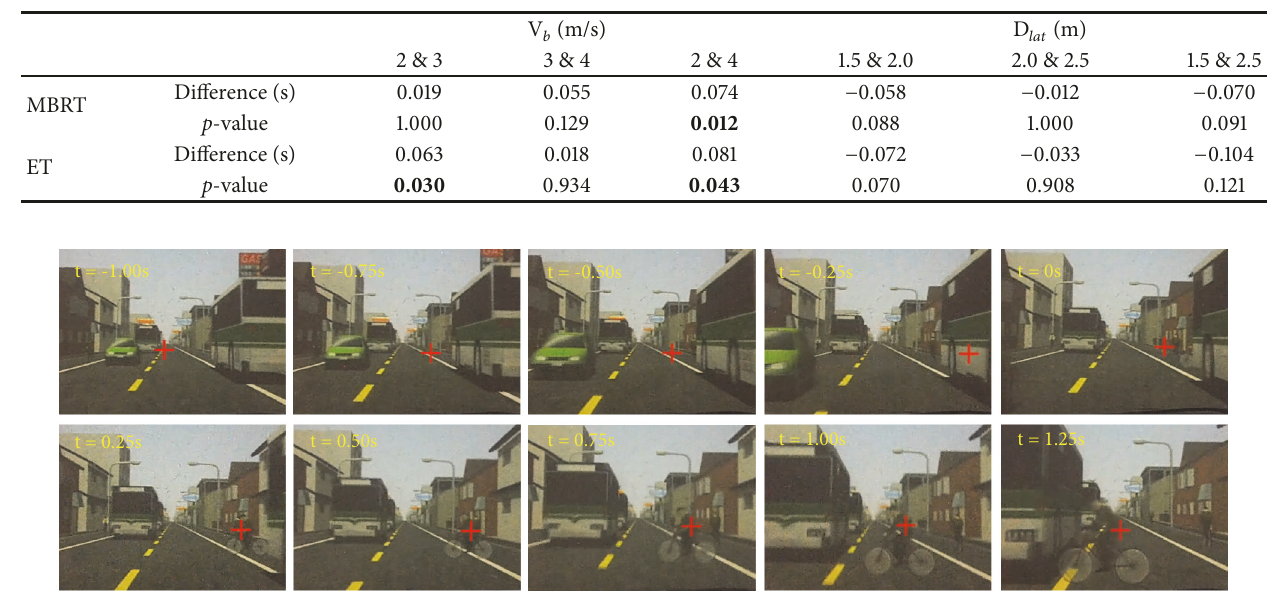
Figure 11: Part of the scene frames captured by the ETG (the red cross indicated the driver’s gaze point). t = 0s is the moment of the bicycle triggering. t = 0.25s is the moment when the driver started gazing at the bicycle, i.e., the moment when the stimulus was established.